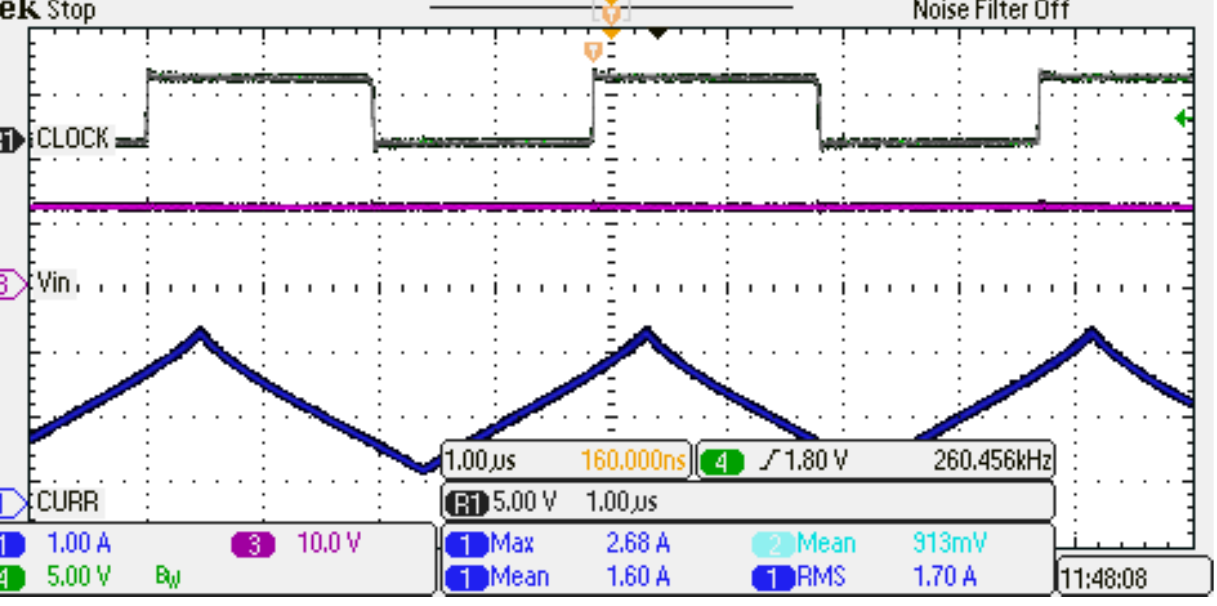
Figure 8. Experimental curve of the current (bottom). The top trace, labelled as CLOCK, is the inter ‐ nal reference signal accessed by the pin “SYNC” of the EVM.